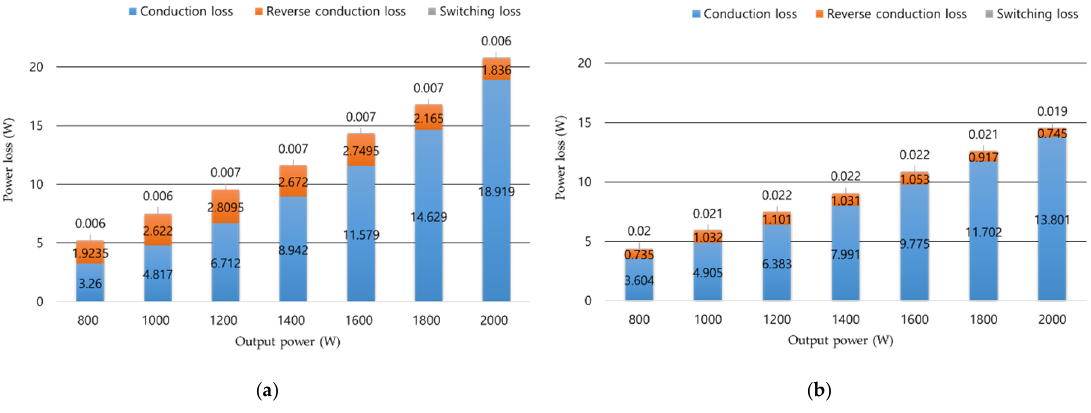
Figure 6. Loss breakdown according to the output power: ( a ) GaN HEMT; ( b ) SiC MOSFET.